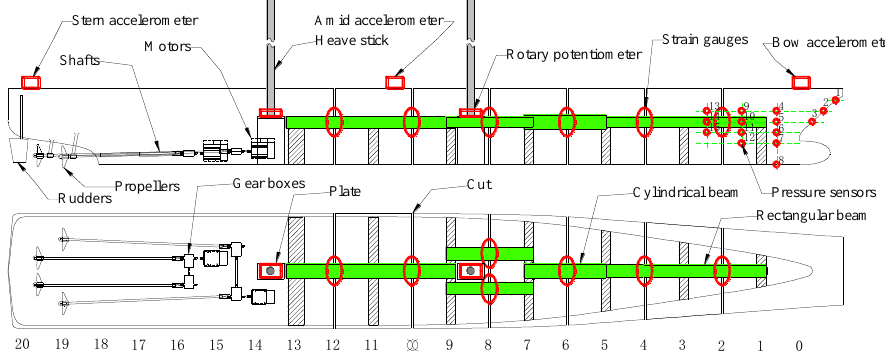
Figure 4. Sensor arrangement on the small-scale model.